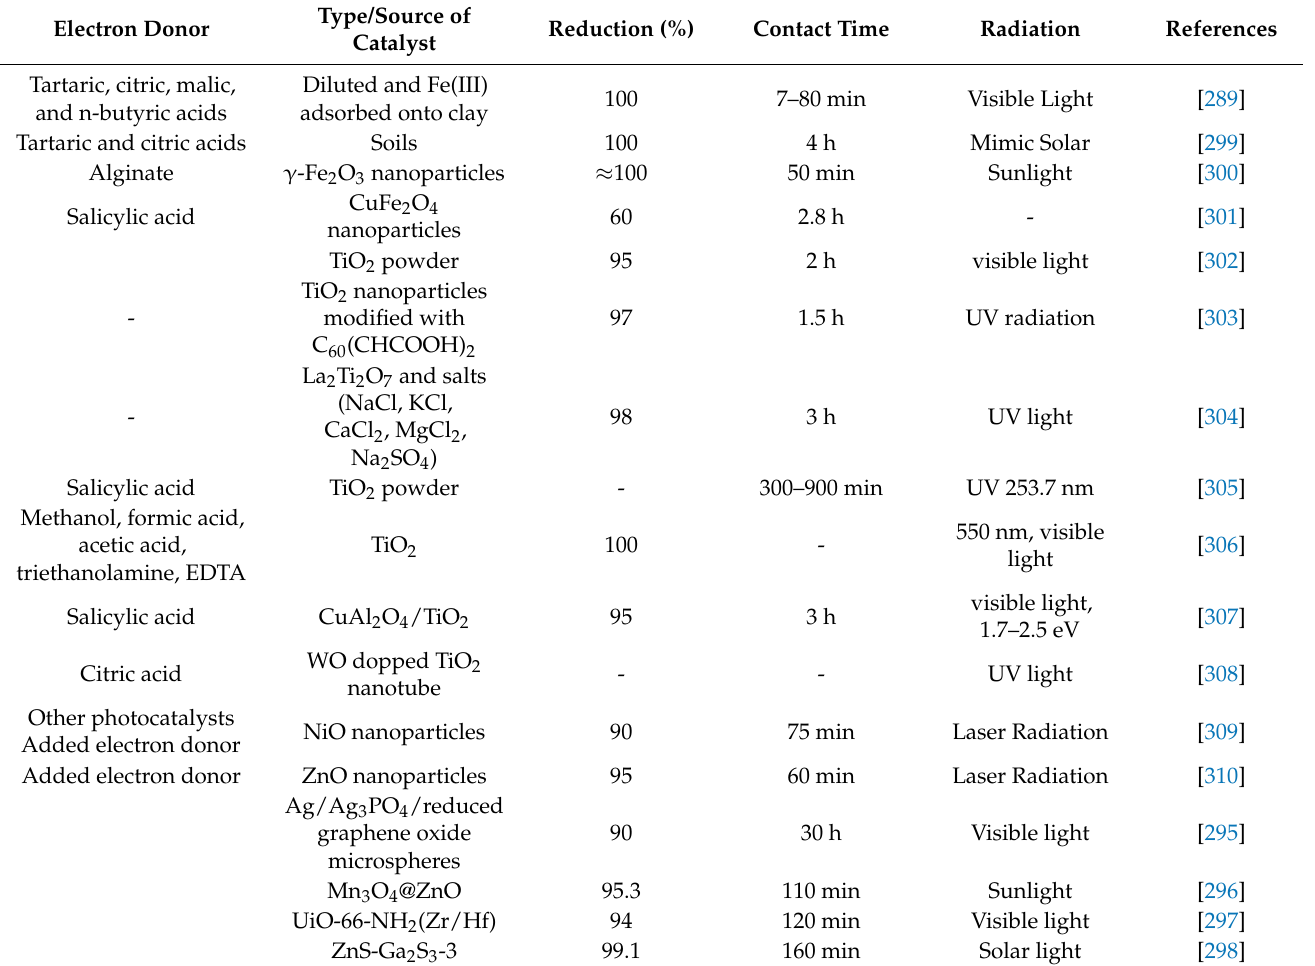
Table 5. Photocatalytic degradation and reduction of available used catalysts in the